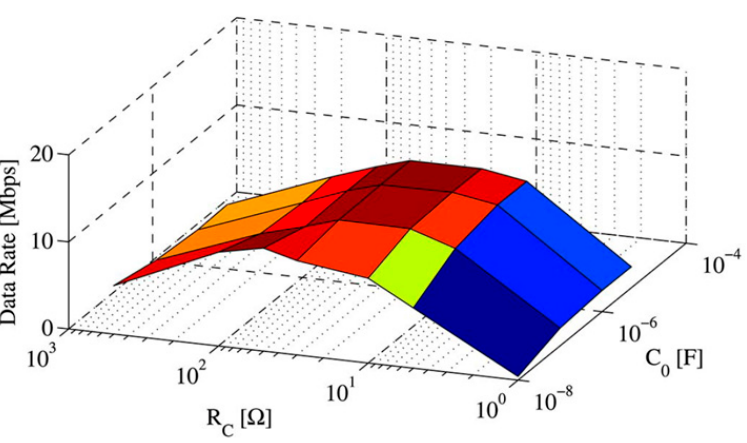
Figure 3. Maximum experimentally achieved data rate as a function of R C and C 0 , in an OFDM scenario targeting a BER < 2 × 10 − 3 . Reproduced with permission from reference [63].